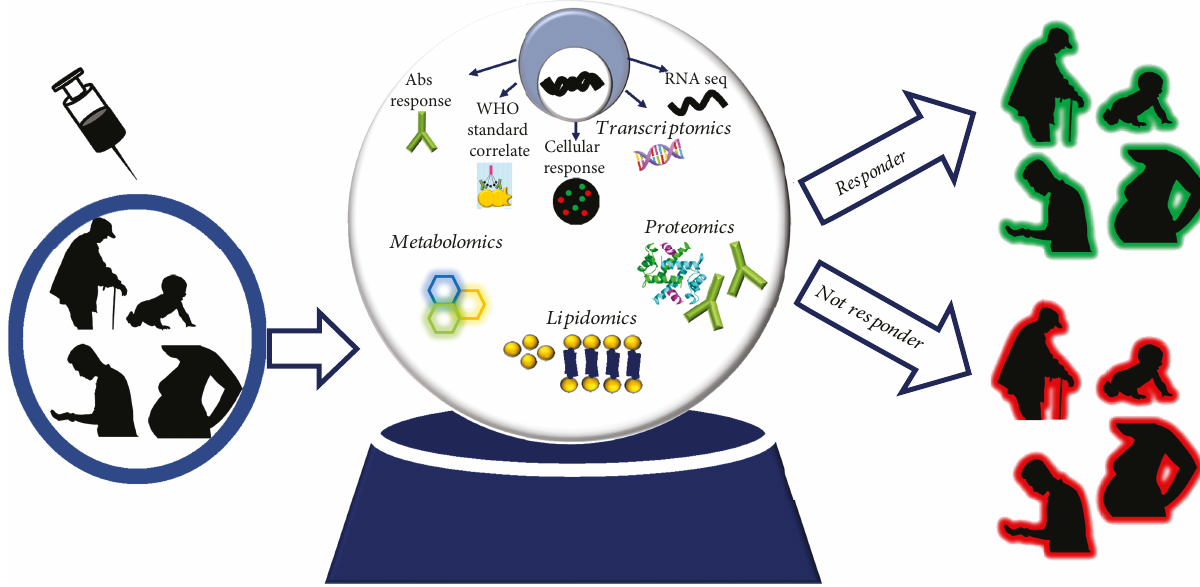
Figure 1: Conventional and system biology “ OMICs ” technologies [35] currently available to predict vaccine-induced immune